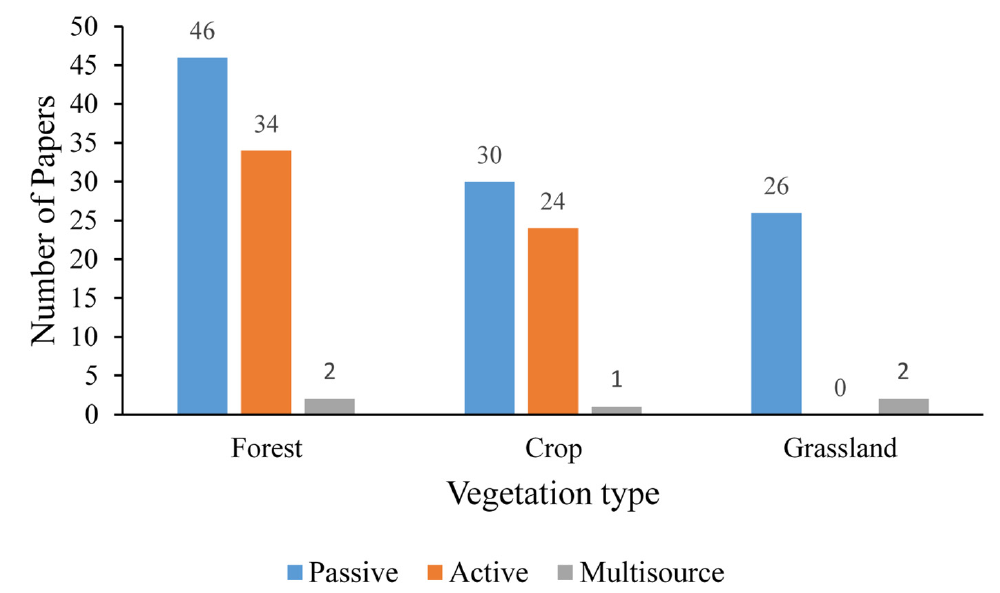
Figure 6. Application of different sensor systems for forest, crop and grassland.